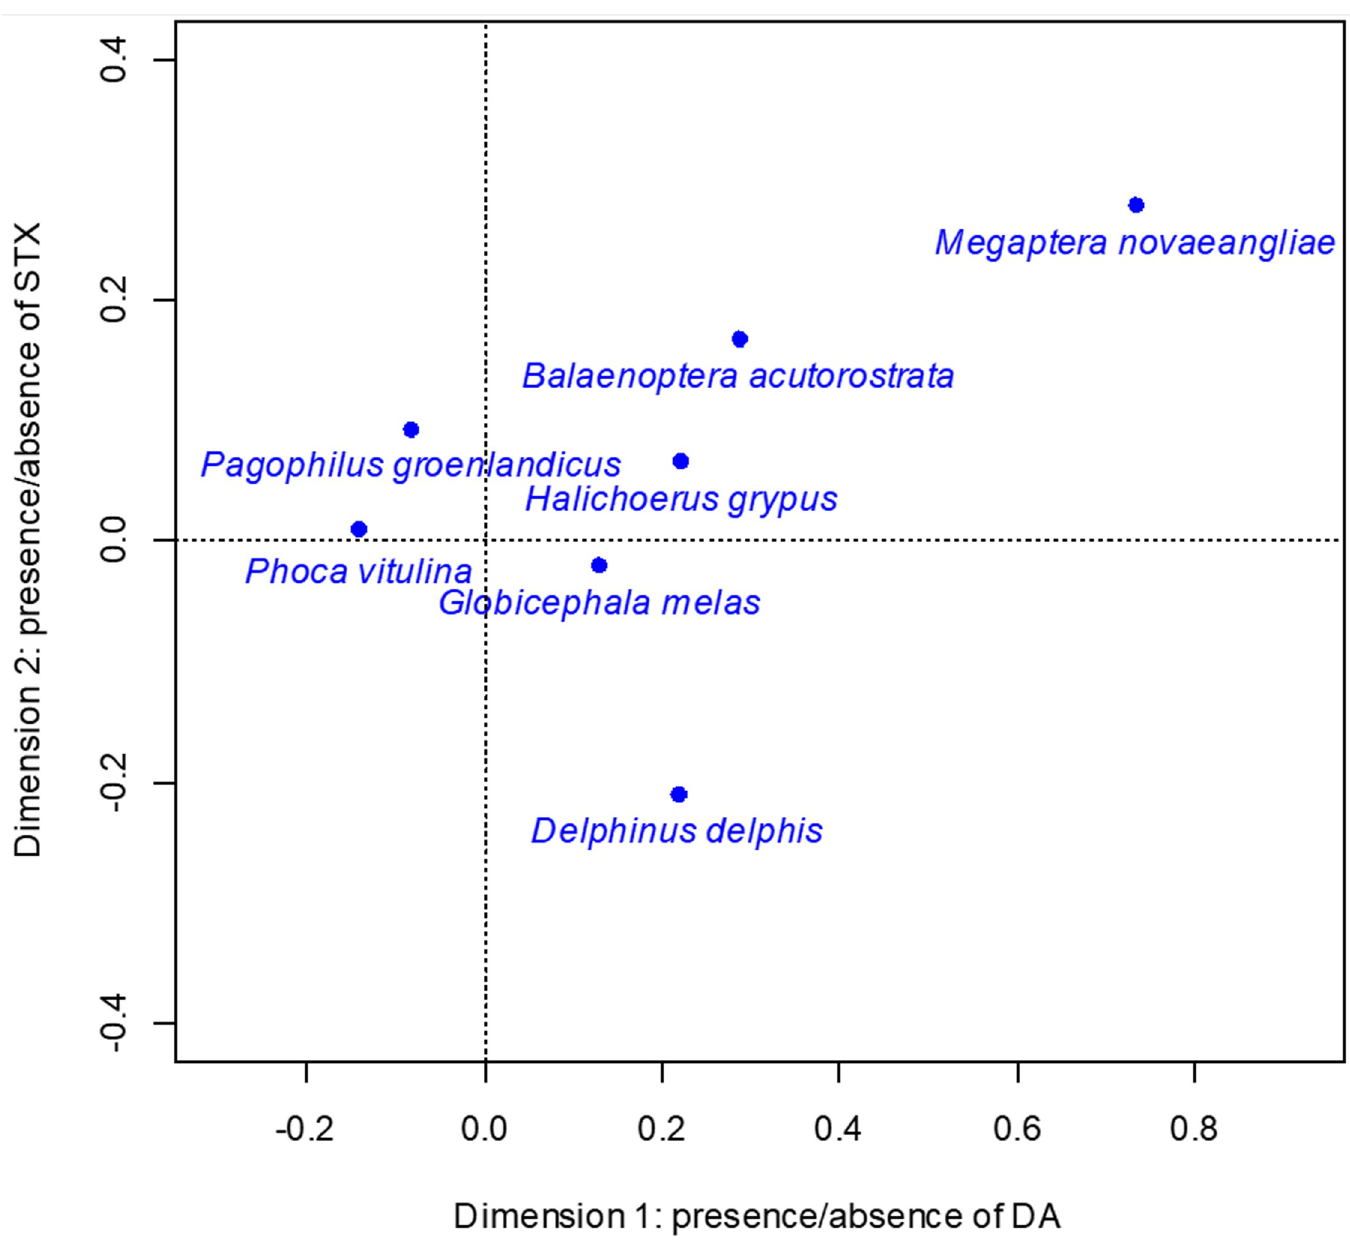
Fig 5. Correspondence analysis ordination for species comparisons. Positive values for dimension 1 correlate with larger proportion of positive domoic acid samples and negative values correlate with larger proportion of negative domoic acid samples. Positive values for dimension 2 correlated with larger proportion of positive saxitoxin samples and negative values correlate with larger proportion of negative saxitoxin